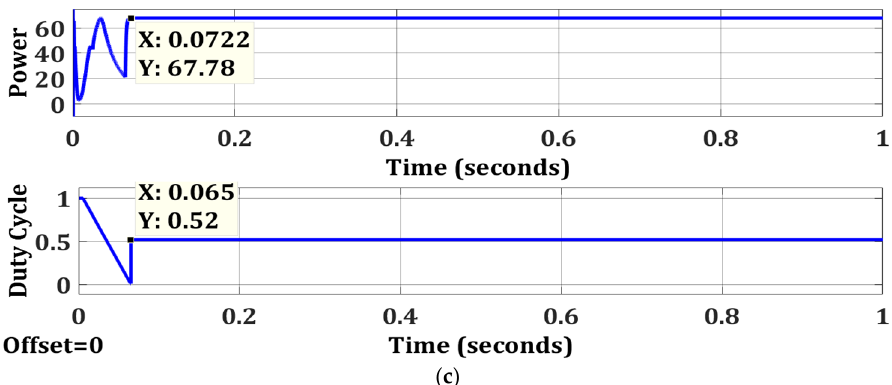
Figure 40. Simulation results for 2S2P PV system : ( a ) ten check algorithm for test case 1; ( b ) ten check algorithm for test case 2; ( c ) ten check algorithm for test case 3. Table 11. Performance comparison of OTCA for 2S2P PV system for all test cases .